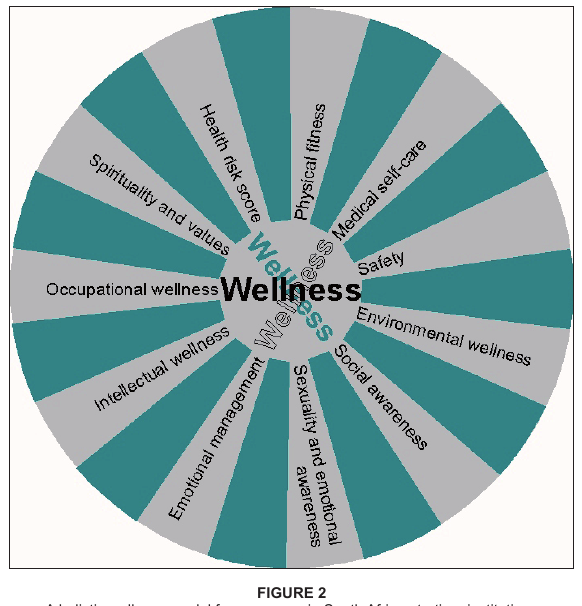
FIGURE 2 A holistic wellness model for managers in South African tertiary